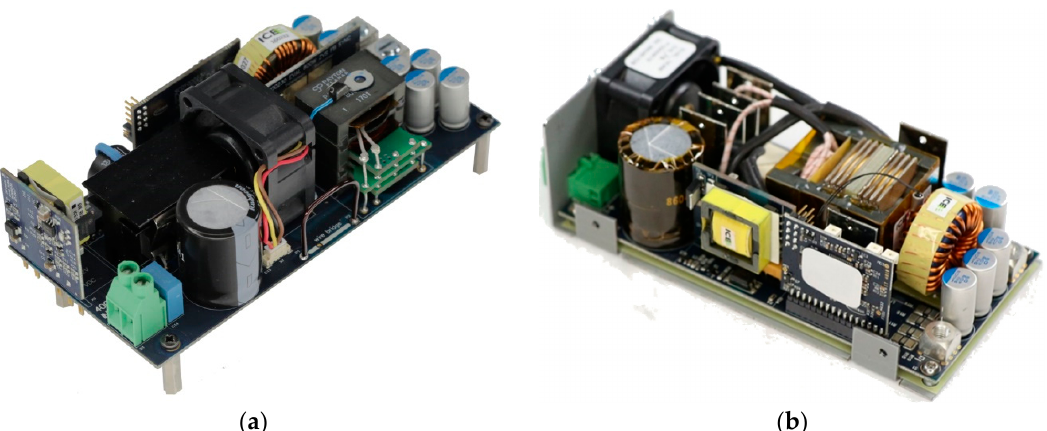
Figure 20. Prototypes of PSFB DC-DC converter for server applications: ( a ) original reference design; ( b ) optimized design.